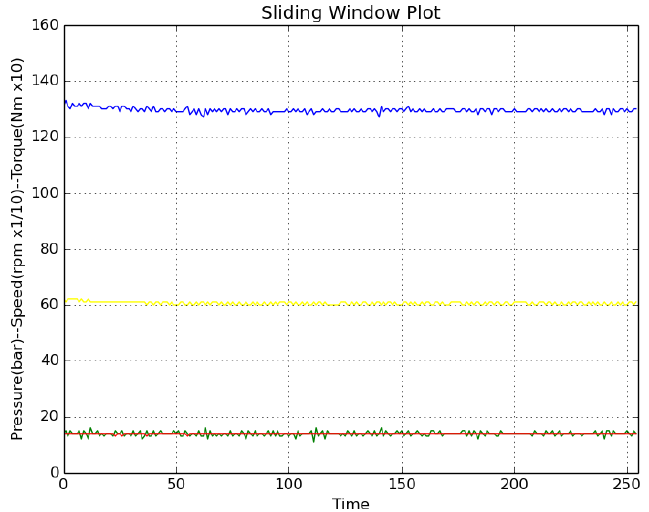
Figure 15. Pump running at constant pressure (130 bar).